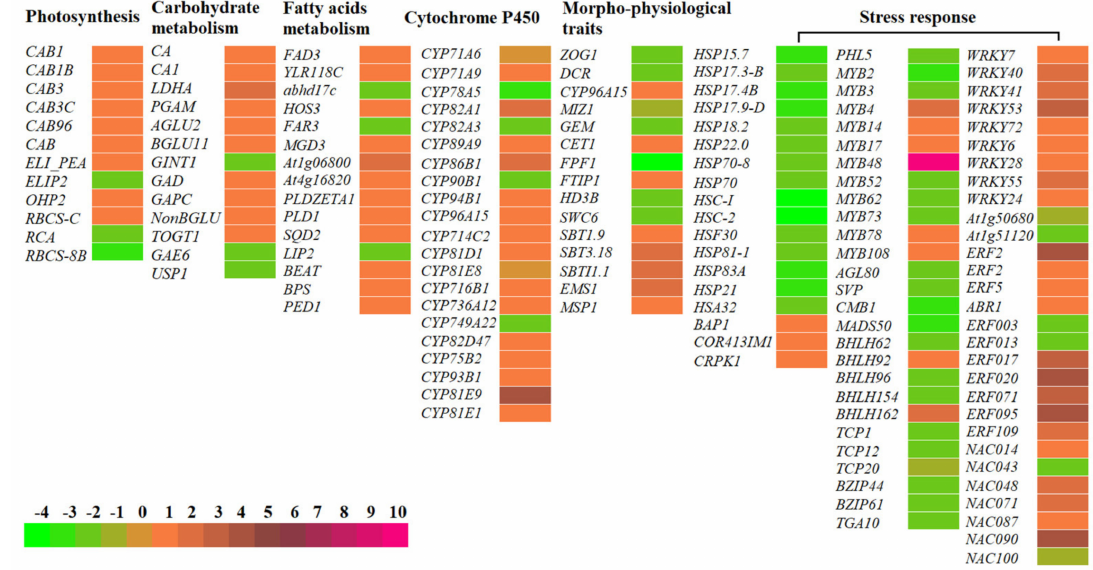
Figure 5. Heat map of the differential gene expressions at 15 versus 22 ◦ C, based on the normalized Reads Per kb per Million (RPKM) values. Abbreviations of the genes are listed in Tables